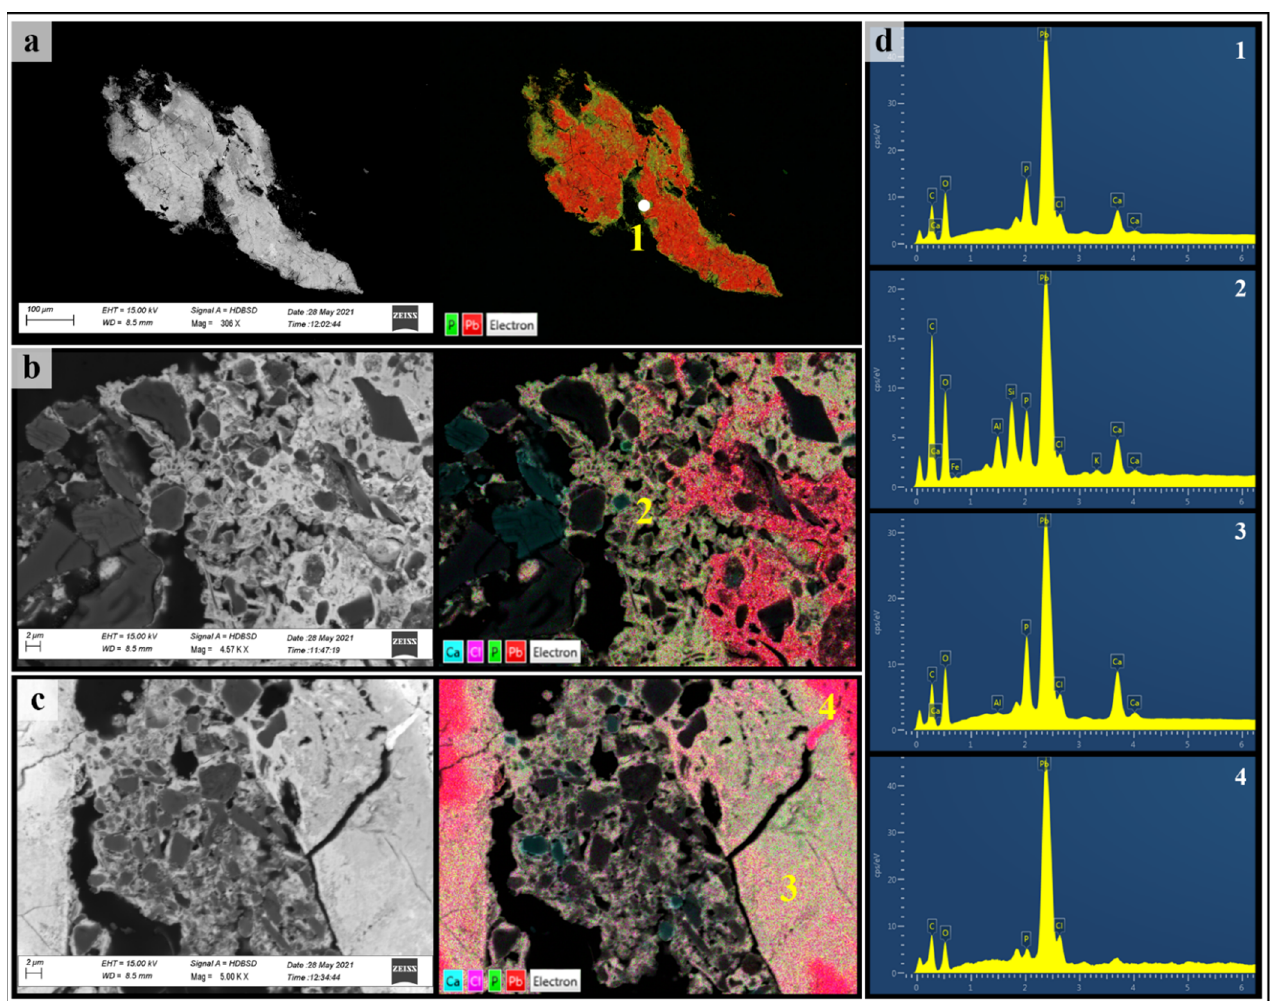
Figure 4. ( Left panel ) BSE micrographs of a Pb-containing particle. ( b , c ) Higher magnification details of the weathering crust of the particle shown in ( a ). ( Middle panel ) EDX layered images. ( d , right panel ) EDX spectra of the points (white in ( a )) and/or regions (yellow numbers in ( b , c )) indicated within the middle panel: (1) typical EDX spectrum of the P-bearing coating at particle boundaries; (2) Pb–Ca phosphates matrix in a silicate environment forming an aggregate-like structure; (3) com- pact Pb and Ca phosphate solid solution; (4) metallic or weakly weathered